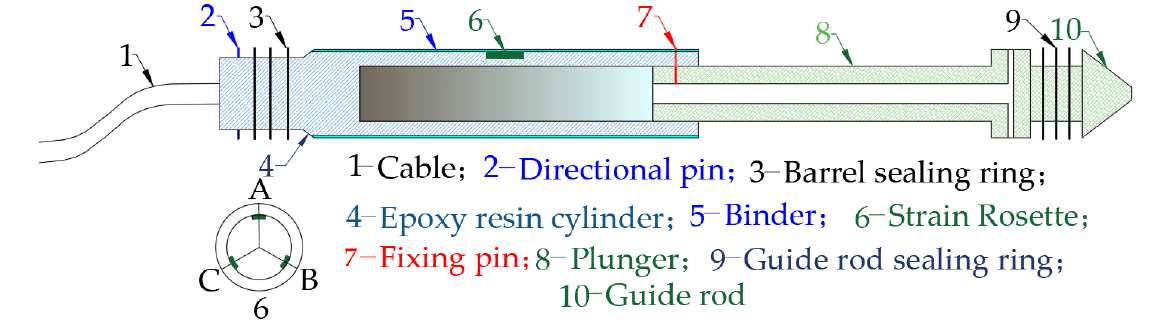
Figure 3. Hollow—inclusion stress gauge.